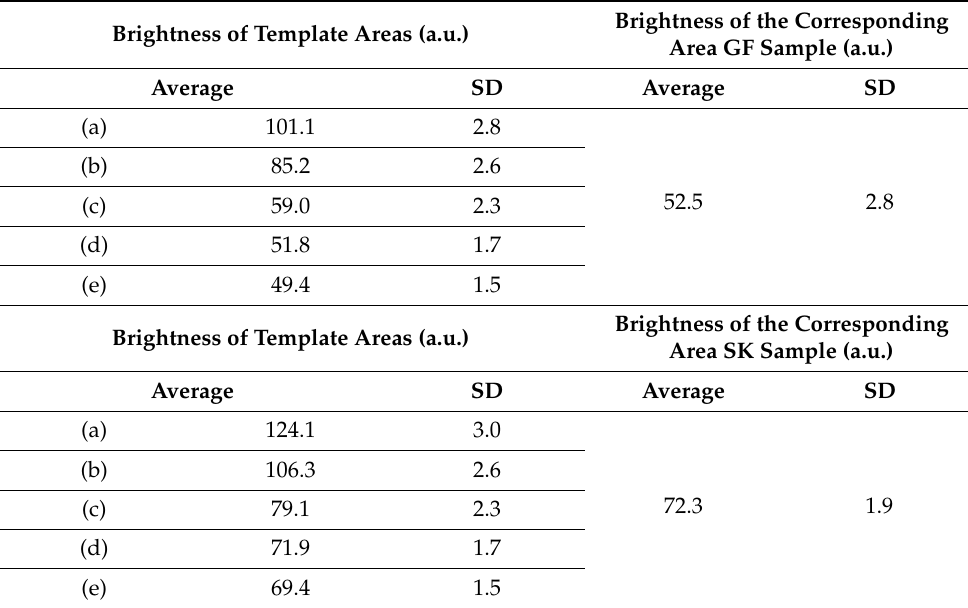
Table 1. Cont. Brightness of Template Areas (a.u.)